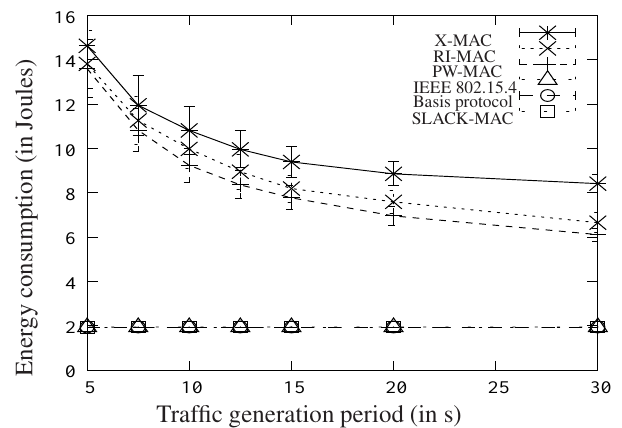
Figure 9. Energy consumption as a function of the traffic generation period, for a duty-cycle of 1 %, and for several